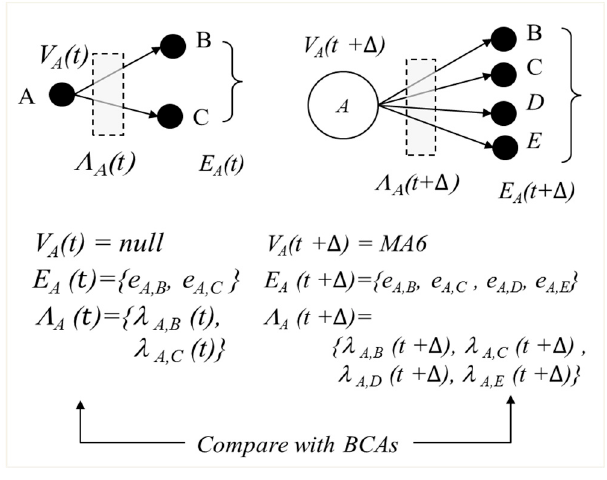
Figure 2. Generation of G A.